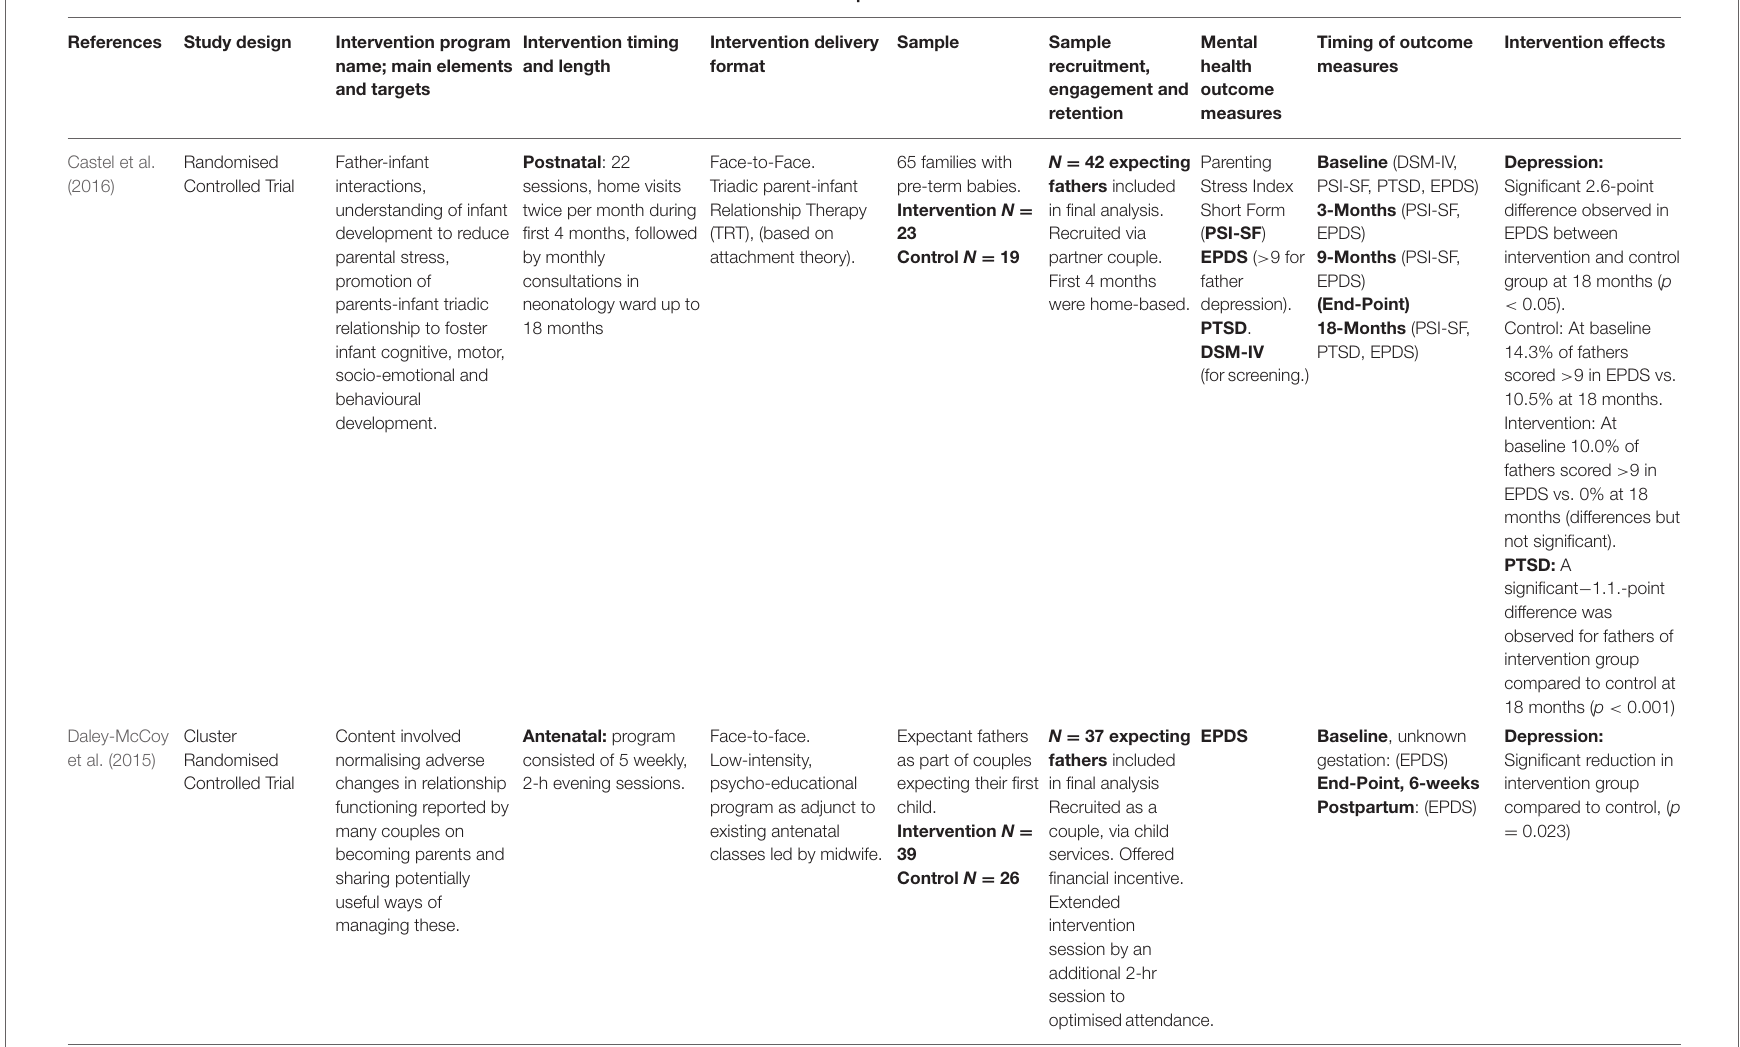
TABLE 1 | Published interventions reporting on men’s perinatal depression or anxiety,